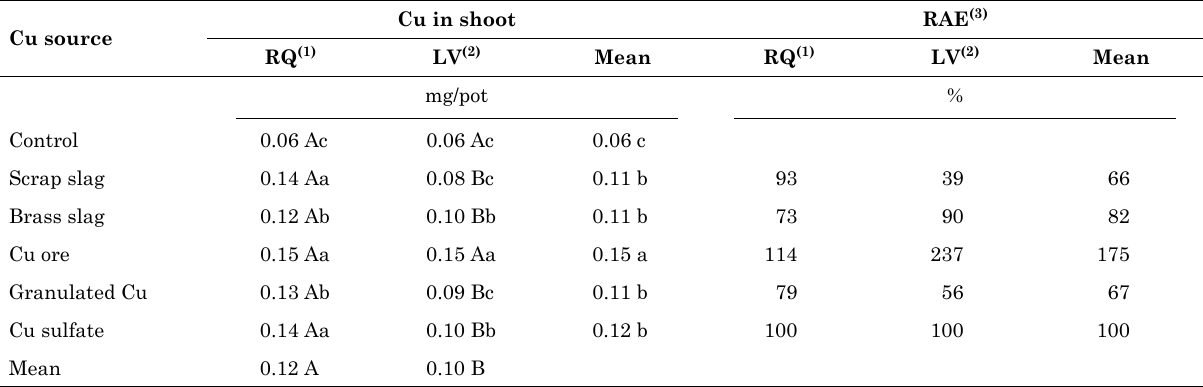
Table 6. Copper accumulation in wheat shoots and relative agronomic efficiency (RAE) of the Cu sources in comparison with Cu sulfate (100